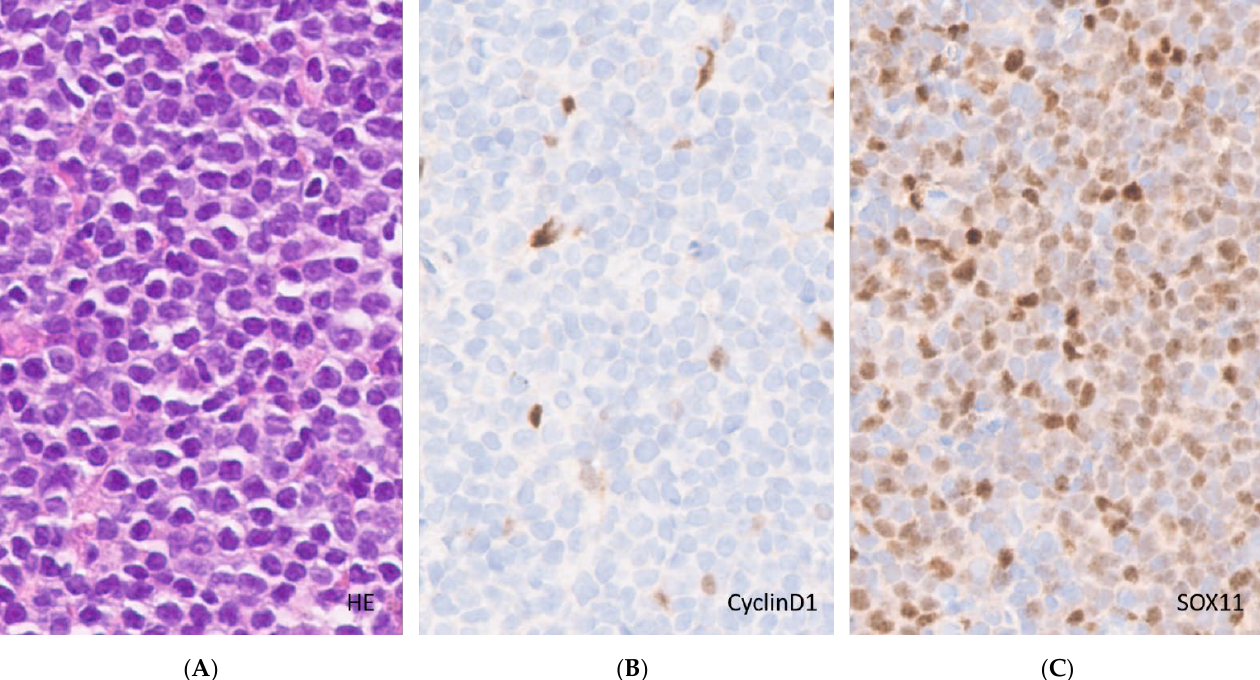
Figure 3. Cyclin D1-negative MCL. ( A ). White pulp expansion by monomorphous neoplastic cells (H&E, original magnification ×40); ( B ). Cyclin D1 immunohistochemistry staining endothelial cells and histiocytes only (original magnification ×40); ( C ). SOX11 immunohistochemistry, nuclear staining of the tumor cells (original magnification ×40).